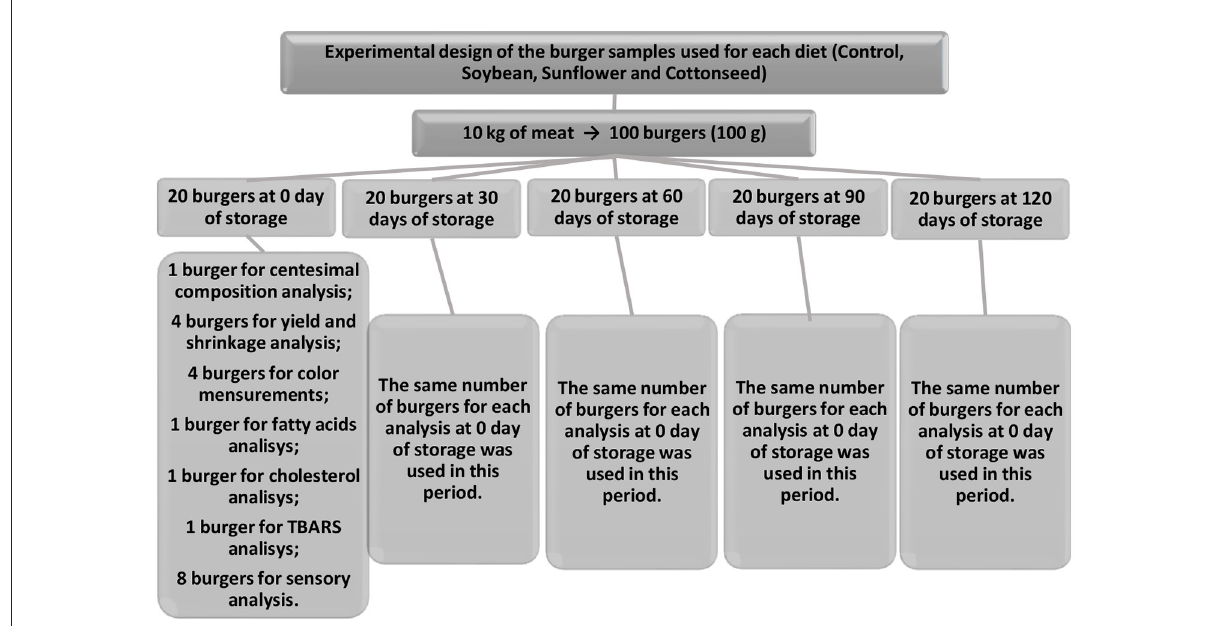
FIGURE1 Quantity and distribution of burgers in the diets and centesimal, instrumental and sensory